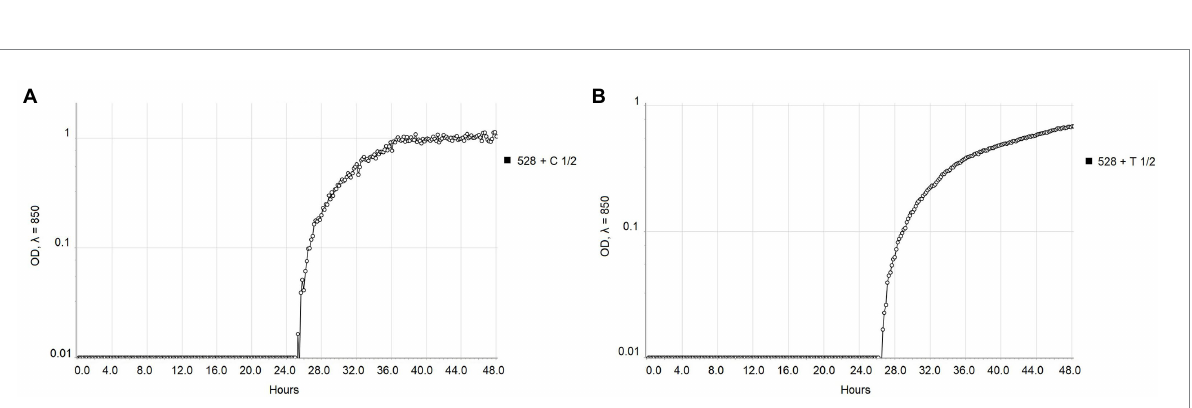
FIGURE 2 Comparison of the growth of Xanthomonas campestris pv. campestris NCPPB 528 T treated with ½ MIC values of (A) carvacrol and (B) thymol measured by Cell Growth Logger (OD 850 , 48 h period, log 10 scale).